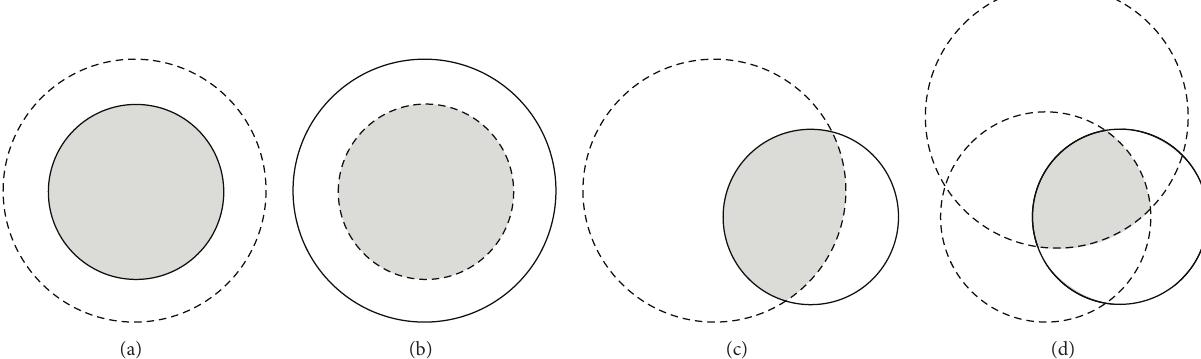
Figure 2: Overlaying the potential intervals of Data A (solid line), Data B (dashed line), and Data C (long dashed line). Shaded area indicates the optimal potential interval (PI).